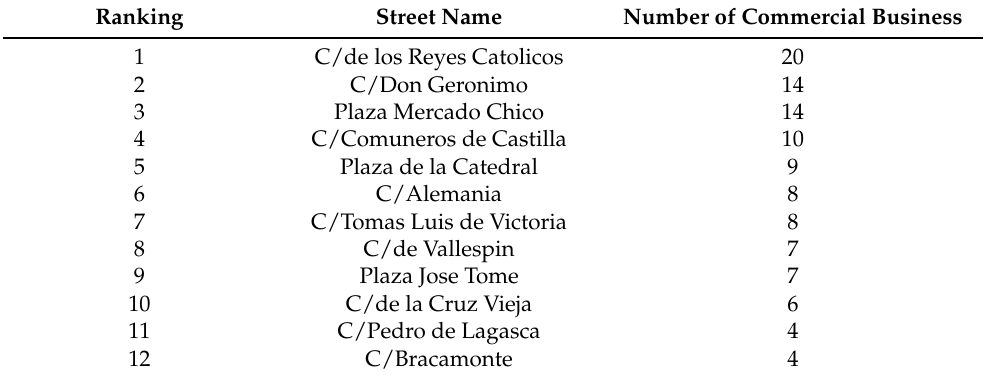
Table 4. Main streets in terms of the number of commercial businesses.